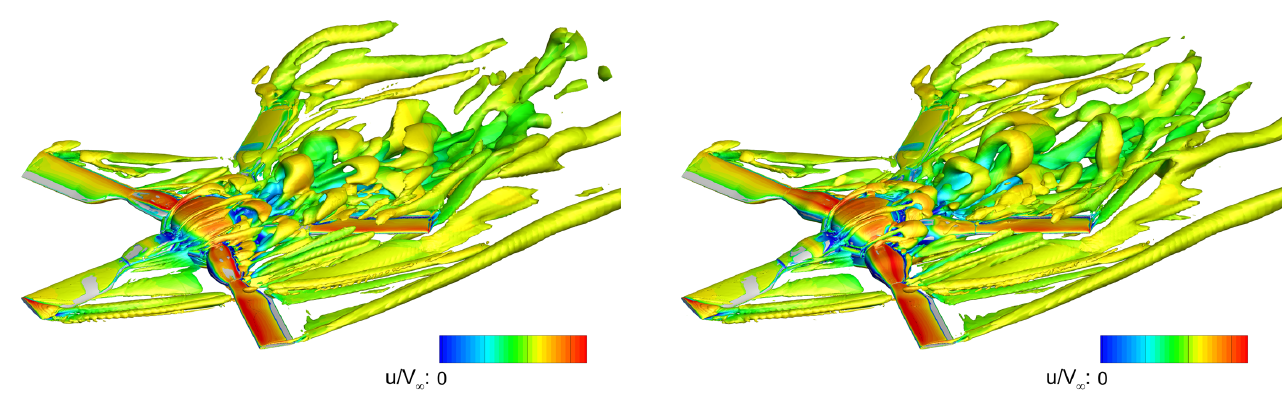
Figure 23. Iso-surface of the Q-criterion ( Q = 2000 s − 2 ), which is colored by the normalized axial flow velocity u / V ∞